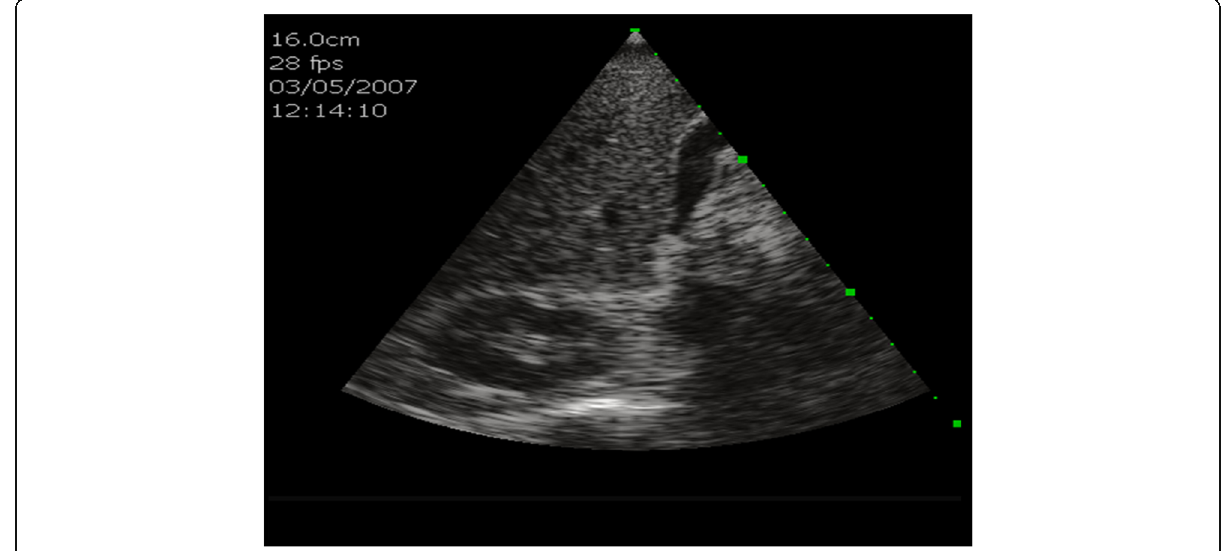
Fig. 3 Acuson P10 Siemens: B-scan ultrasound of the liver, including the gall bladder and the right